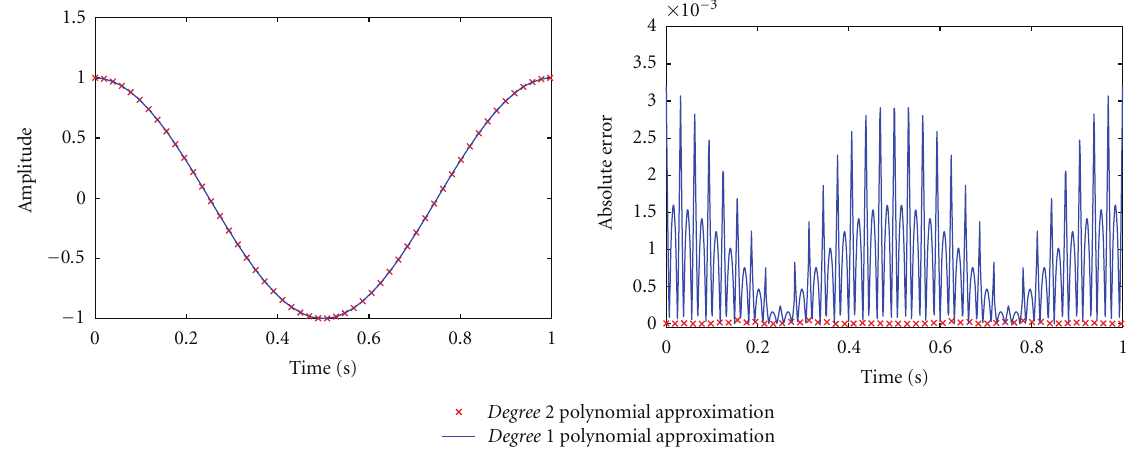
Figure 2: Approximation of a cosine function with degree 1 and degree 2